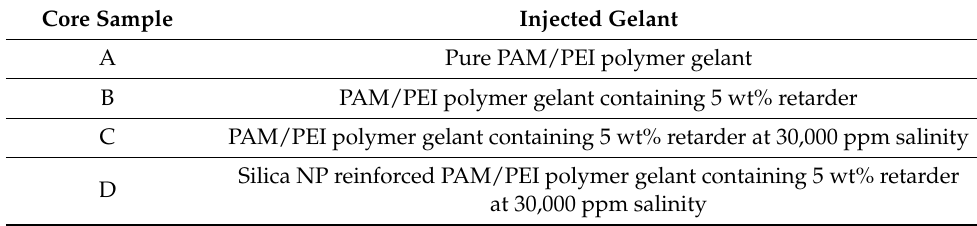
Table 1. The core and injected polymer gelant.